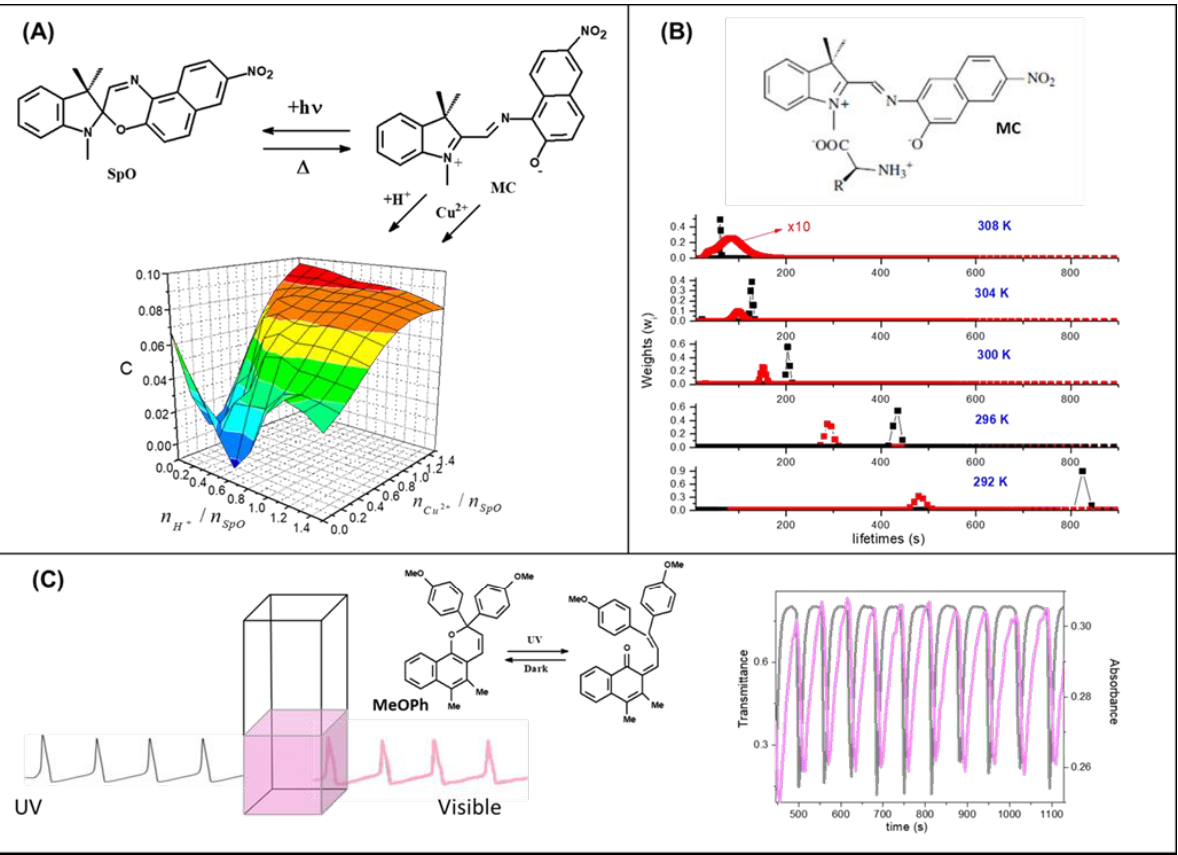
Figure 7. Smooth analog dependence of the SpO’s colorability on the chemical inputs H + and Cu 2+ , in ( A ) [78] . Lifetimes’ distributions for the merocyanine MC as a function of temperature and with (black points) and without (red points) the ammino-acid, in ( B ) [75]. Periodic variation of color’s saturation for the naphthopyran MeOPh receiving a periodic UV signal, in ( C ) [86].